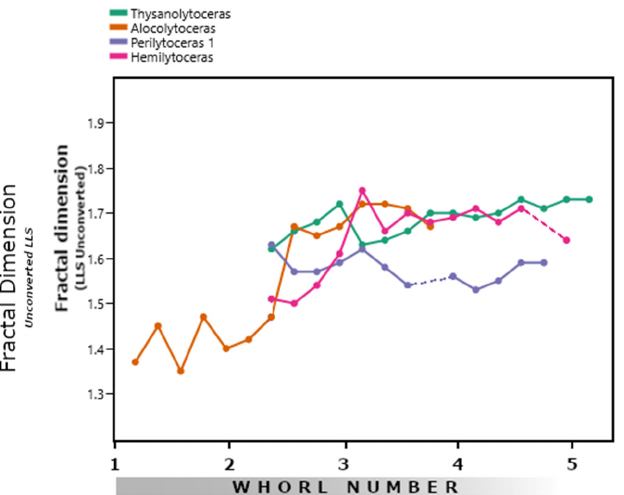
Figure 3. Ontogenetic sequences of lytoceratids. The dashed lines indicate unusable sutures within the ontogenetic sequence. The fractal dimensions can be found in File S1 in the Supplementary Materials.